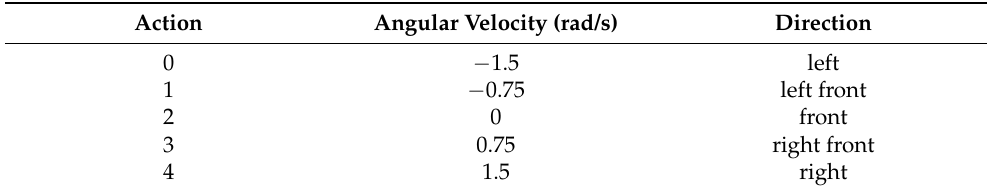
Table 2. Correspondence table between motion and angular velocity.